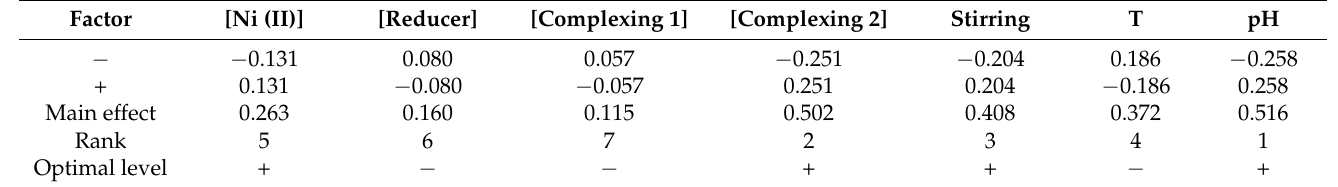
Table 8. Main effect chart on wear and corrosion resistance of ENP coatings for multivariate optimization.